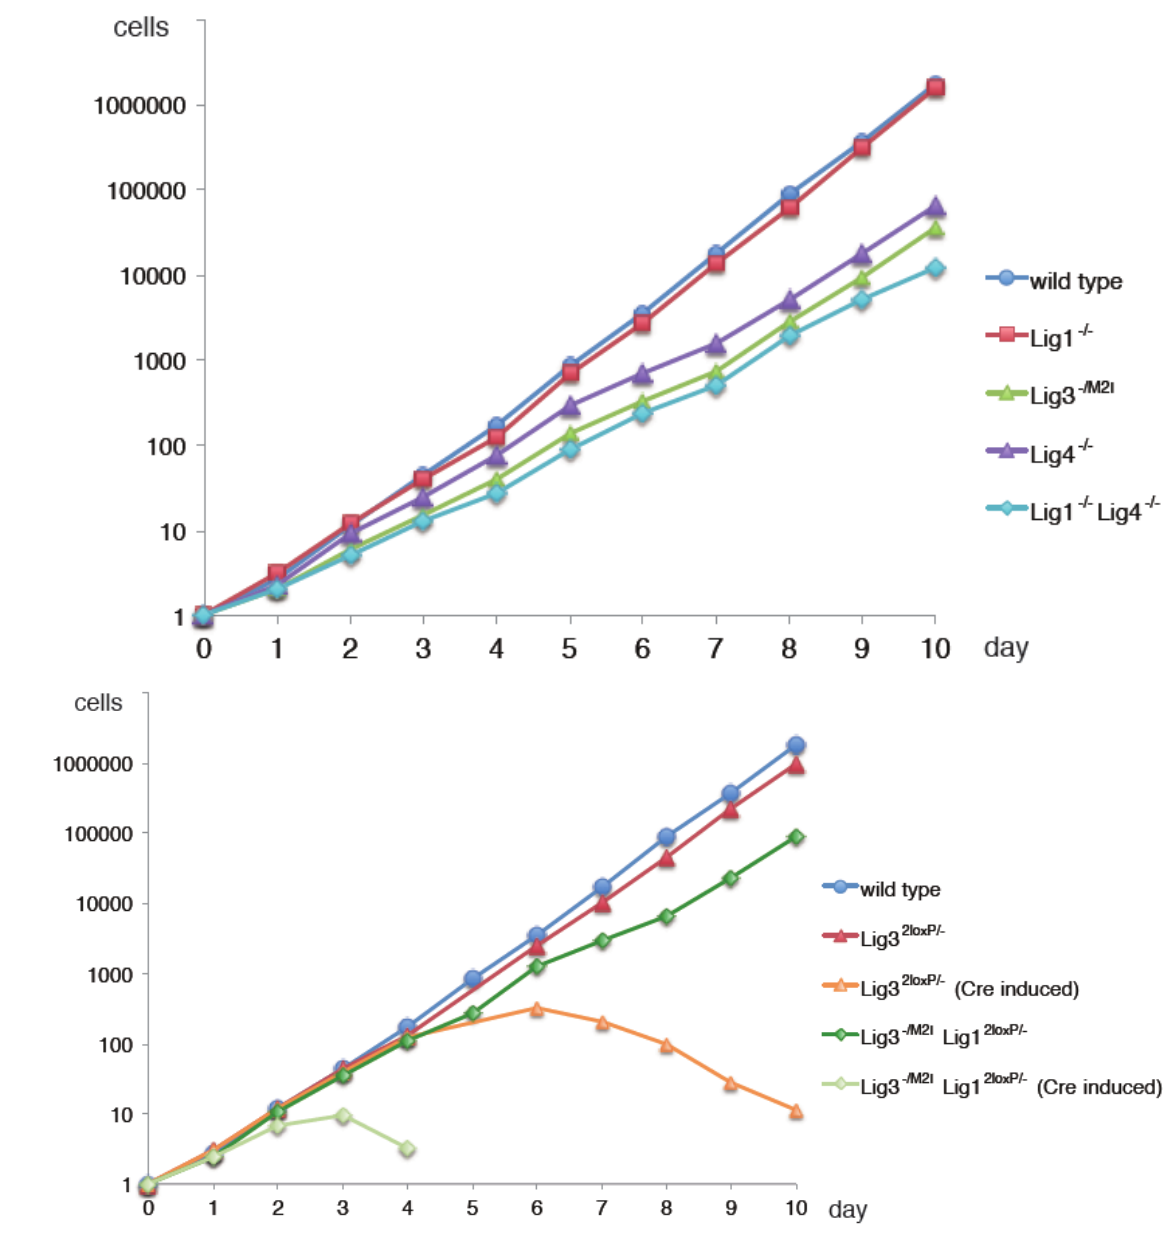
Figure 2. Synthetic lethality between Lig1 and nuclear Lig3. ( A ) Growth kinetics of wild-type and DNA ligase knockout DT40 cell lines; ( B ) Growth kinetics of wild-type and DNA ligase conditional knockout DT40 cell lines. Lig1 2loxP/ − : Lig1 conditional knockout, Lig3 2loxP/ − : Lig3 conditional knockout, Lig3 − /M2I : Nuclear-Lig3 knockout. Adapted from